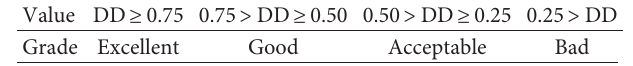
Table 2: Evaluation grades of DD.